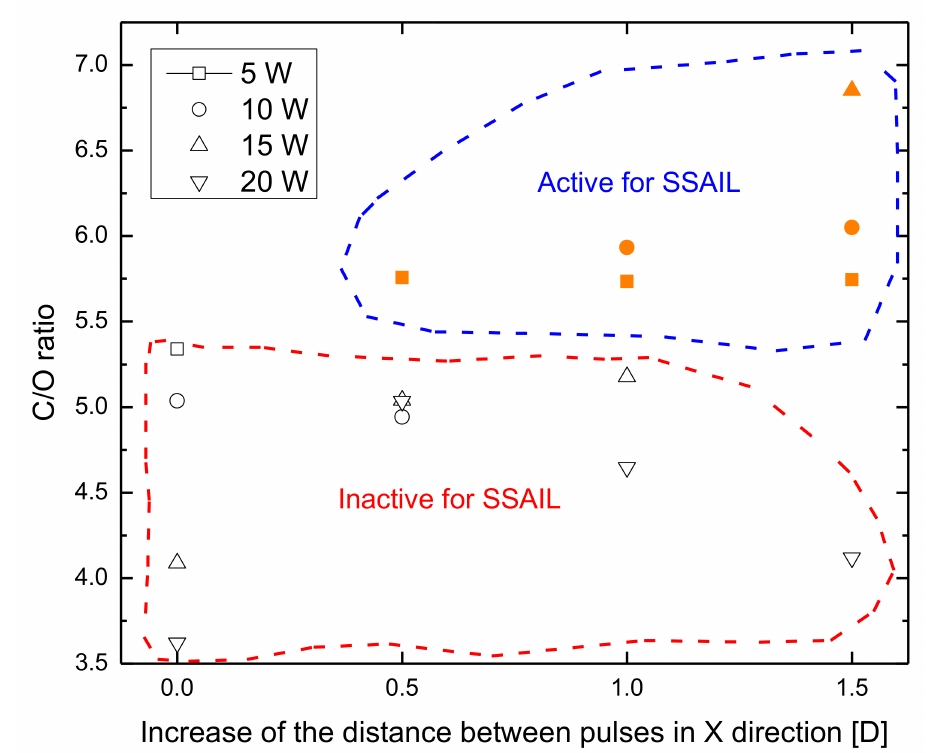
Figure 13. Dependence of the C / O ratio of atomic concentration on laser-modified PC / ABS surface on the distance between pulses in the X direction (measured as a part of pulse diameter) in scanning regime for the first scanning run. The measurements were done by